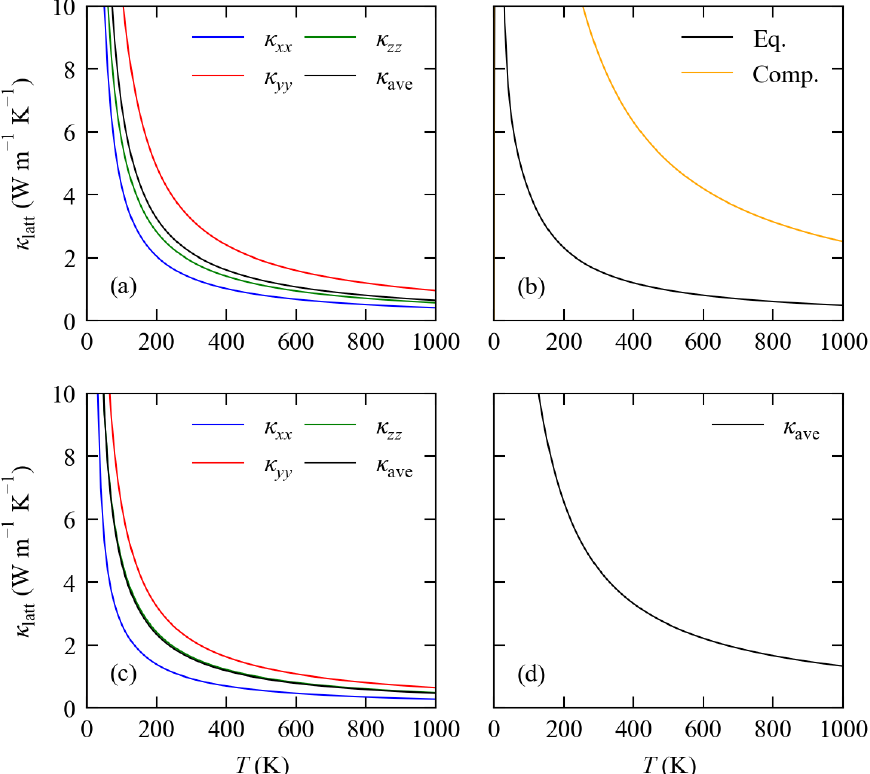
Figure 6. Calculated lattice thermal conductivity κ latt as a function of temperature for Pnma SnS ( a ), equilibrium and compressed rocksalt SnS ( b ), Pnma SnSe ( c ), and rocksalt SnSe ( d ). For the Pnma phases, the principal κ xx , κ yy , and κ zz components of the κ latt tensor, corresponding to transport along the a , b , and c axes, respectively, are shown together with the diagonal average κ ave = (cid:0) (cid:1) 1 κ xx + κ yy + κ zz . For the rocksalt phases, the three diagonal components and the average are 3 equivalent by symmetry, so we only show κ ave . The data for Pnma SnS and SnSe is from [61], but the three principal components have been relabelled to match the orientation of the unit cells in this